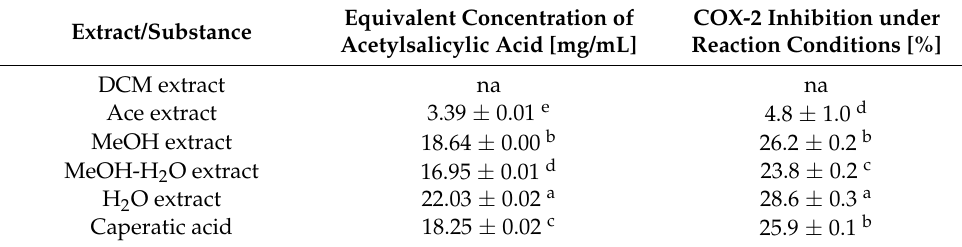
Table 7. Inhibition of cyclooxygenase-2 (COX-2) enzyme by the extracts of P. glauca and caperatic acid. Equivalent Concentration of COX-2 Inhibition under Extract/Substance Acetylsalicylic Acid [mg/mL] Reaction Conditions [%] DCM extract na na